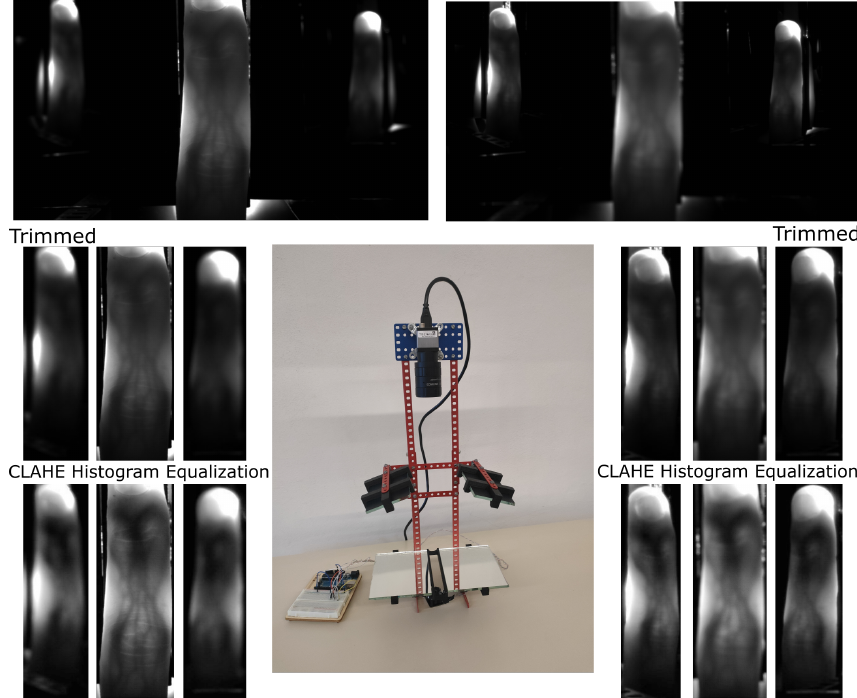
Figure 11. Center picture is image of constructed scanning device. Top left image is scan result focused on direct view on the finger. Top right image is scan focused on reflection of the finger. Second line of images is cut region of interest. Last line is result after using CLAHE histogram